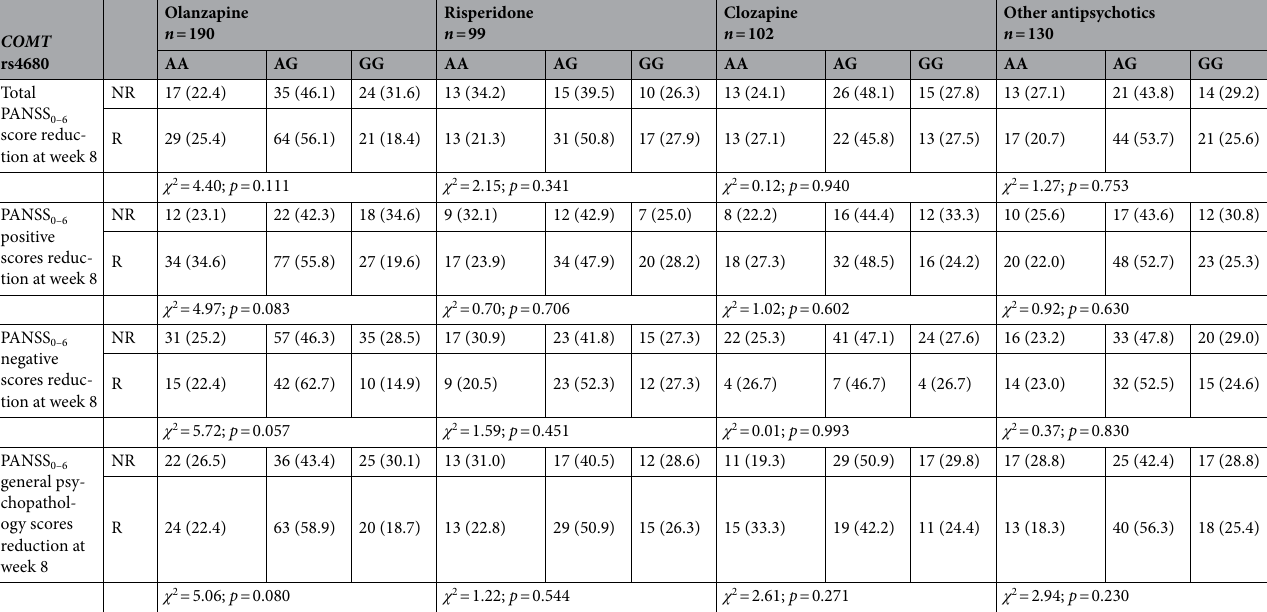
Table 3. The COMT rs4680 genotype count and frequencies in schizophrenia patients treated with olanzapine, risperidone, clozapine or other antipsychotics, subdivided into responders (R) and non-responders (NR) according to the 50% reduction in the baseline PANSS 0–6 total and subscale scores. Frequencies (%) are shown in parenthesis. n number of subjects, NR non-responders, PANSS positive and negative syndrome scale, R responders.